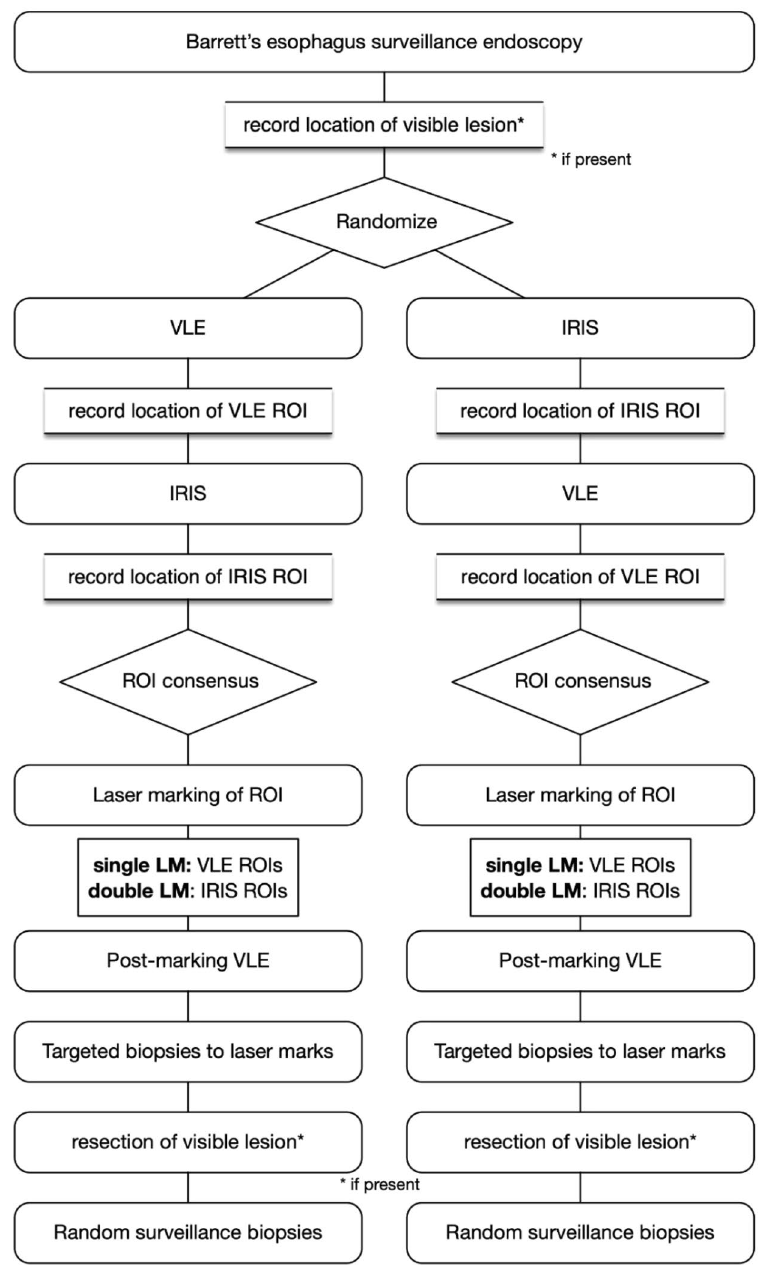
Figure 1. Flow chart of patient allocation and study procedures. ROI—Region of interest; VLE—volumetric laser endomicroscopy; IRIS—Intelligent Real-Time Image